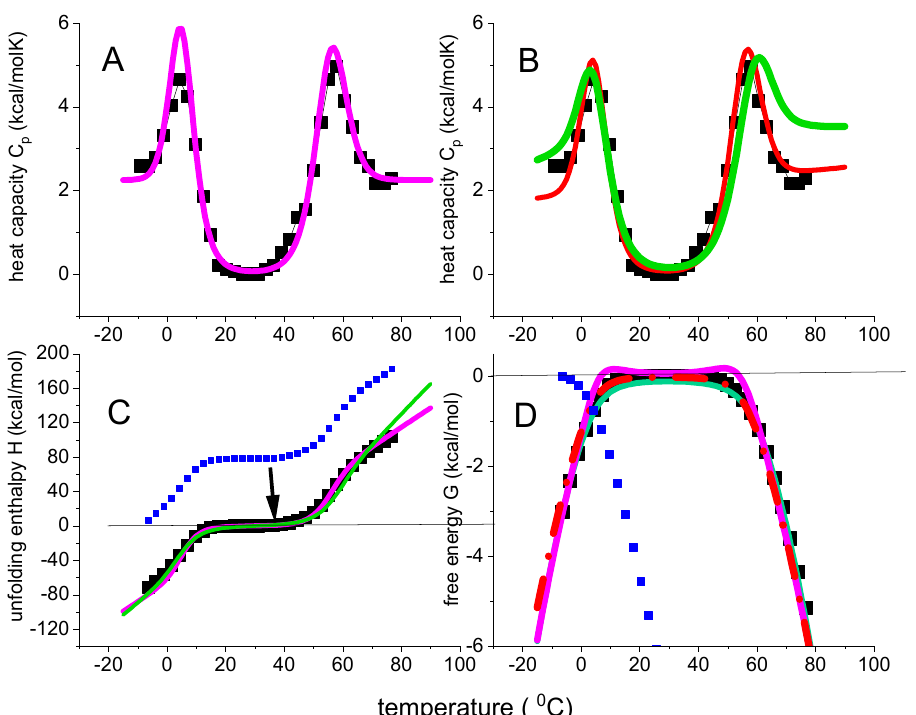
Figure 9. Thermal folding and unfolding of β -lactoglobulin in 2.0 M urea solution. Magenta lines: Θ U (T)-weighted chemical equilibrium model. 0 = 56 kcal/mol; Δ C = 2.4 kcal/moKl. Red lines: statistical-mechanical two-state model. ΔΕ 0 = 55 kcal/mol; C v = 1.2 kcal/molK; Green line: multistate cooperative model. h 0 = 0.58 kcal/mol, c v = 13 cal/molK, σ = 6 × 10 − 5 , N = 80. ( A ) DSC heat capacity data taken from reference [39]. Simulation with the Θ U (T)-weighted chemical equilibrium model. ( B ) Same DSC data as in panel A. Simulations with the statistical models ( C ) Enthalpy Δ H DSC (T). Integration of the C p (T) data according to equation 1 generates the blue data points. The data are then shifted by − 78.3 kcal/mol, the enthalpy released upon cold denaturation, resulting in the black data points. This scale-shift assigns a zero enthalpy to the native protein. ( D ) Free energy. Evalua- tion of C p (T) according to equations 1–3 leads to the blue data points. A related scale-shift for the entropy as for the enthalpy (not shown) and recalculation of the free energy results in the black data points. The free energy change of the native protein is now zero. Cold and heat denaturation gen- erate negative free energies (for more details see reference [15]).